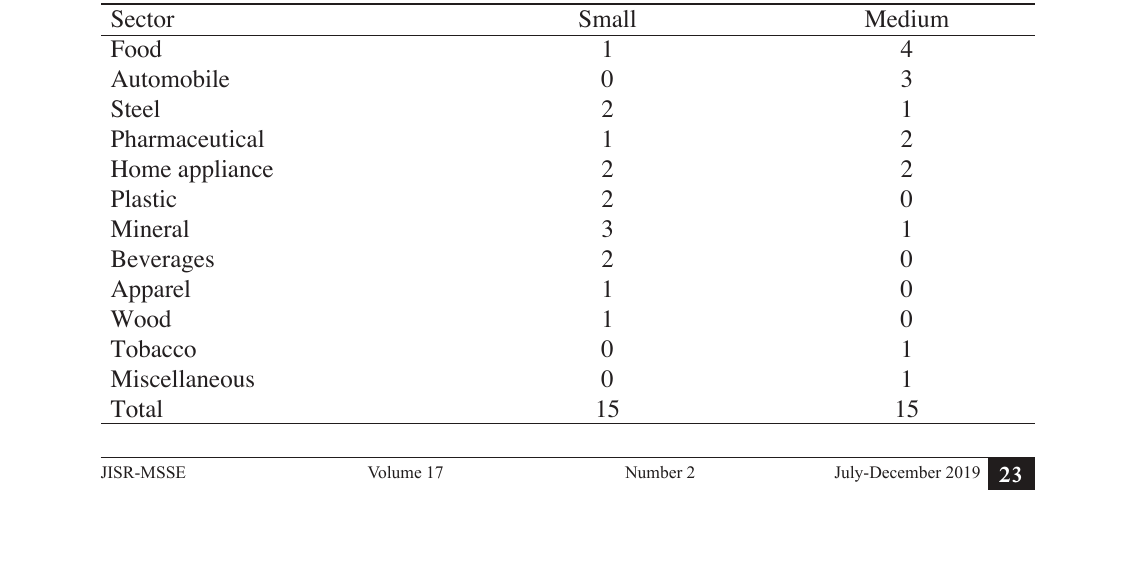
Description of the Sample-size